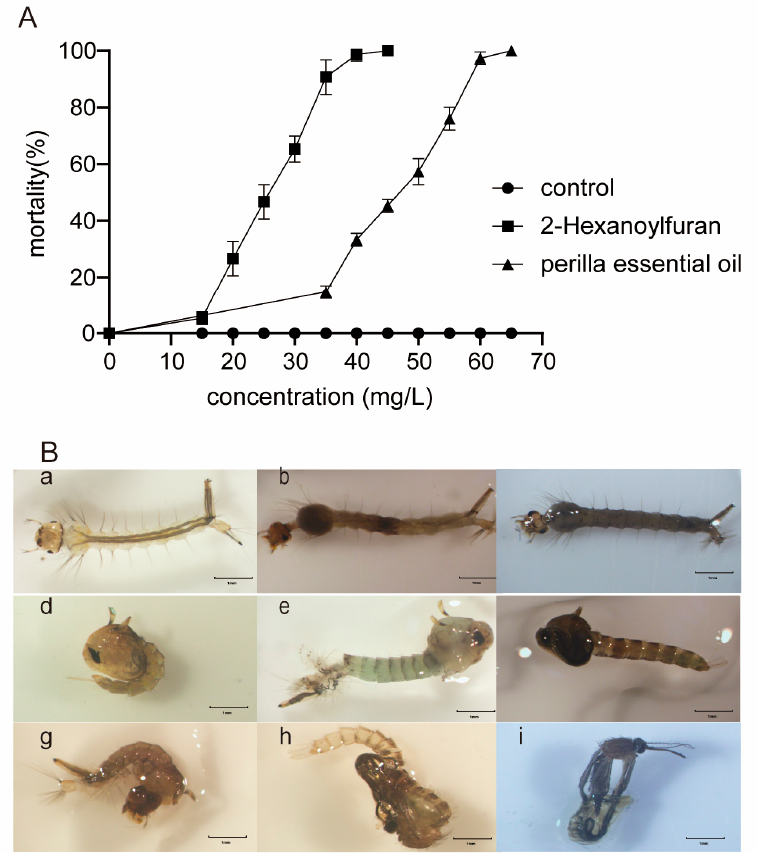
Figure 2. Larvicidal activity of Perilla frutescens essential oil (PE-EO) and 2-hexanoylfuran against Culex pipiens pallens . ( A ) Larval mortality of third-instar larvae of Cx. pipiens pallens post treatment with PE-EO and 2-hexanoylfuran. ( B ) Photographs showing morphological deformities and growth-disruptive symptoms in Cx. pipiens pallens : ( a ) a healthy larva from control; ( b , c ) dead larvae from treatment group; ( d ) a healthy pupa from control; ( e ) larvae with malformation; ( f ) dead black pupa from treatment group; ( g ) larval–pupal intermediates; ( h ) pupal–adult intermediates; ( i ) failed emerging adults.